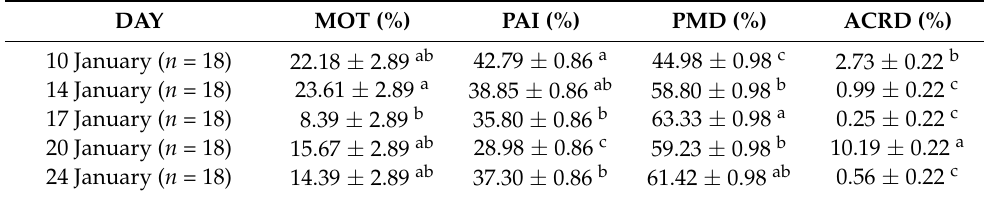
Table 2. The impact of daily variation on the motility (MOT), plasma membrane and acrosome intactness (PAI), plasma membrane damage (PMD), and acrosome damage (ACRD) of thawed rooster sperm (least square means ± standard